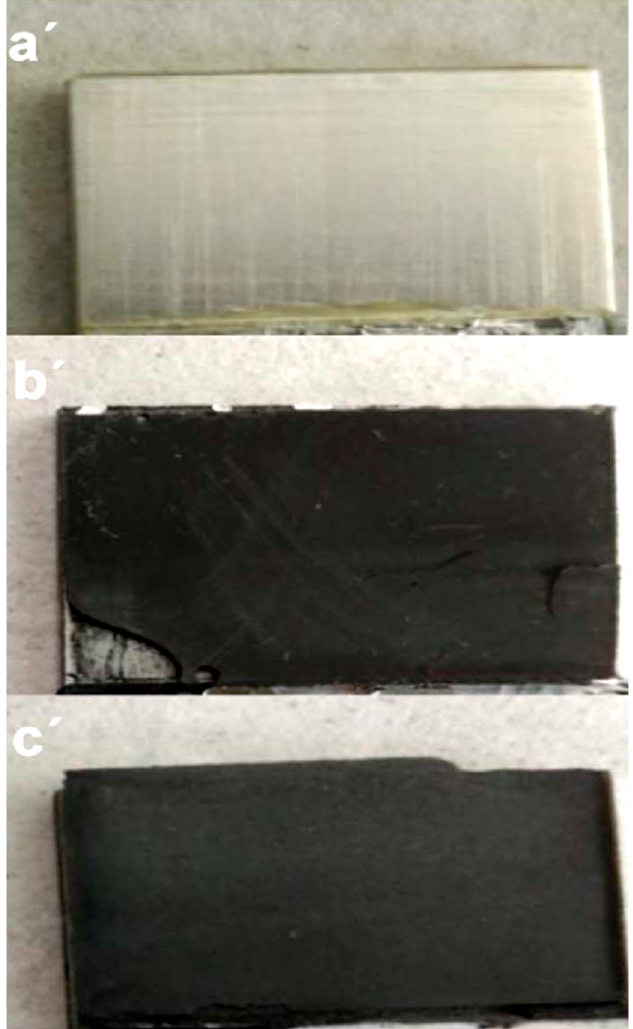
Figure 10. Failure surfaces of epoxy adhesives on aluminum joints: ( a’ ) epoxy; ( b’ ) 6 wt.% GNP-NH 2 ; ( c’ ) and 6 wt.% GNP. GNP = graphene nanoplatelets; GNP-NH 2 = amine-functionalized graphene. Reprinted with permission from [120]. 2018, Elsevier.